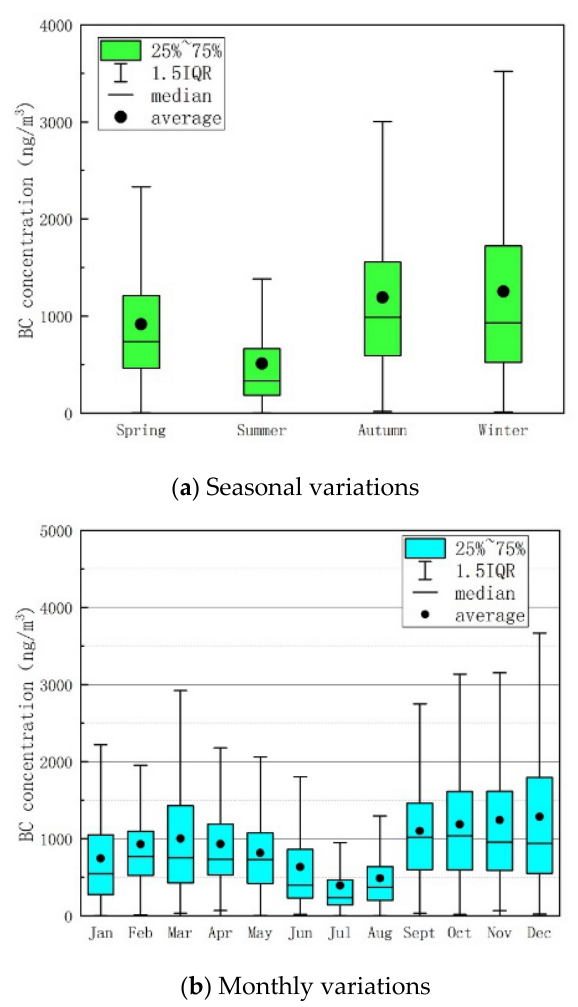
Figure 2. Seasonal and monthly variations in BC in 2018. ( Note: The box and whisker plot shows the range of BC concentration.; the centerline of each box is the median, the box represents the 25th through 75th percentile; the whiskers represent the most extreme value within 1.5 times the interquartile range).